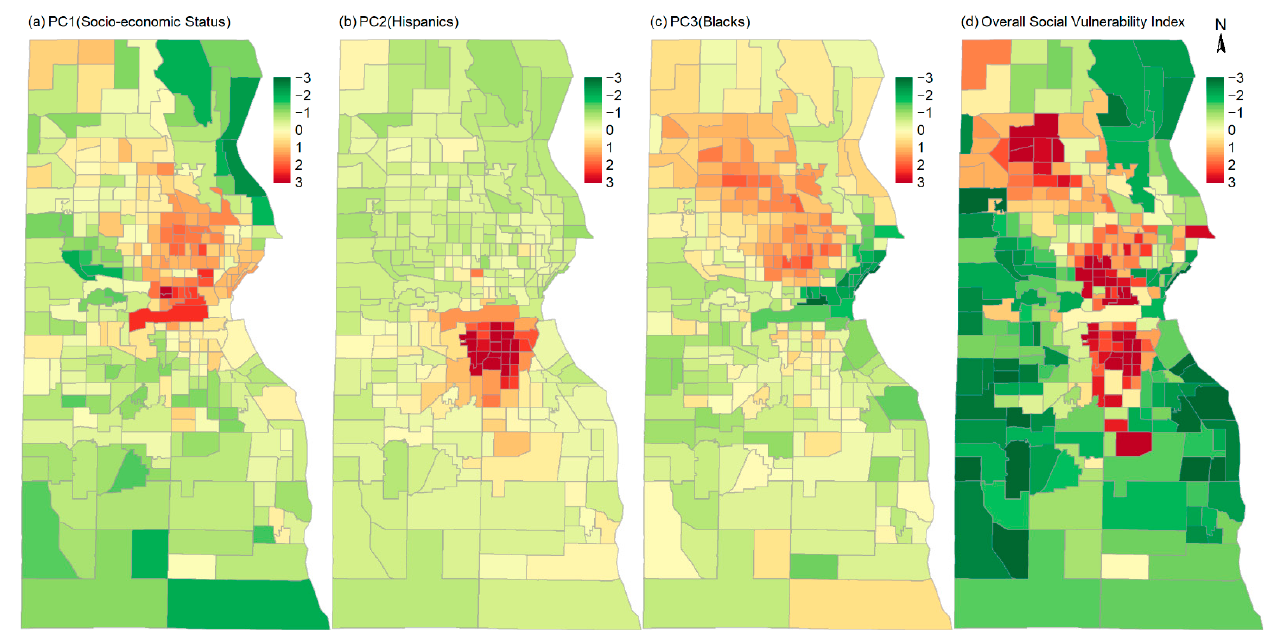
Figure 2. Spatial distribution of the score of the three major principal components (PCs): ( a ) PC1 representing general socio-economic status (SES); ( b ) PC2 representing Hispanics; ( c ) PC3 representing non-Hispanic Blacks; and ( d ) the value of the overall social vulnerability index (SVI) in census tracts in Milwaukee.